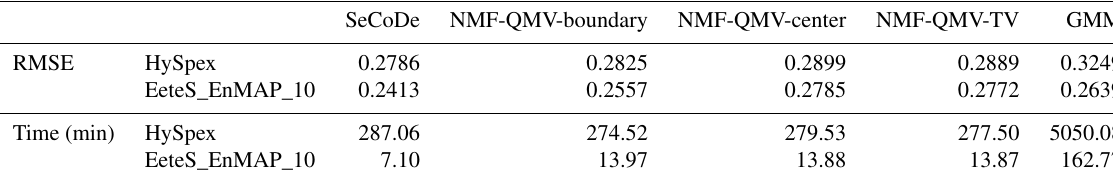
Table 5. Quantitative assessment of unmixing algorithms for the sub2 region.